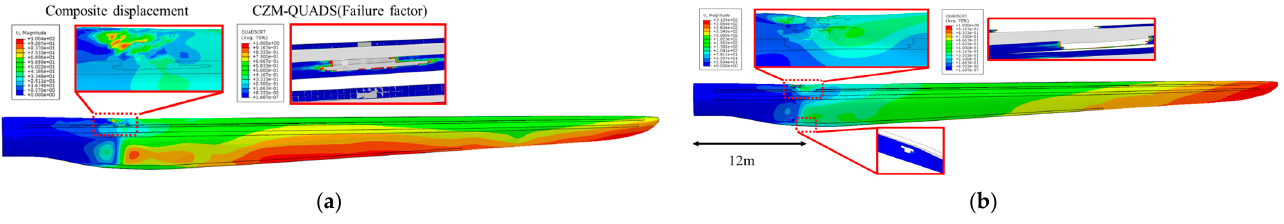
Figure 21. Displacement and failure shape depending on the full-scale blade: ( a ) 90% of reference load and ( b ) 200% of reference